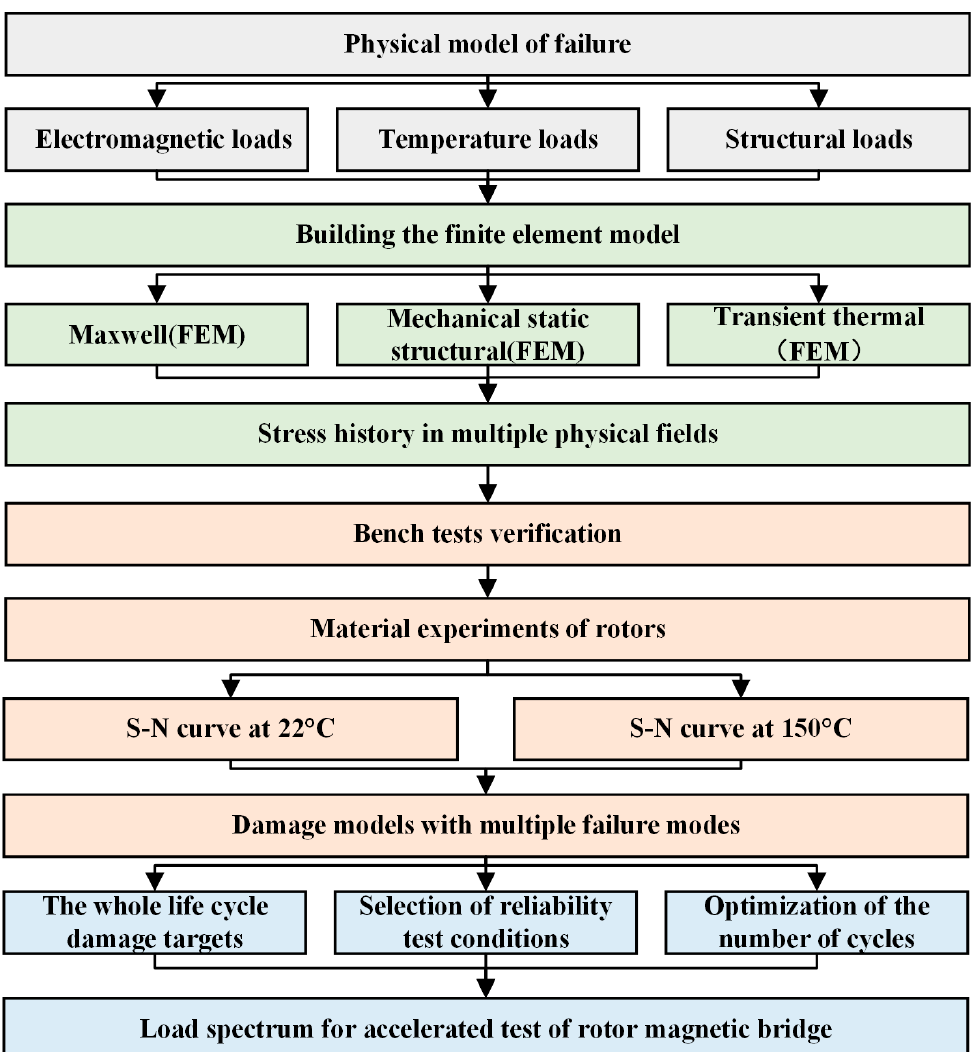
Figure 1. Technical routes.